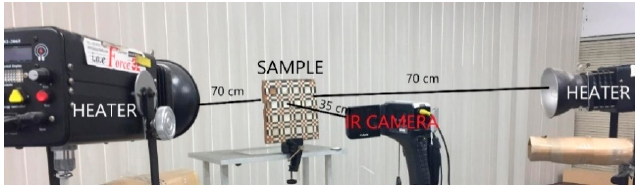
Figure 3. Experimental